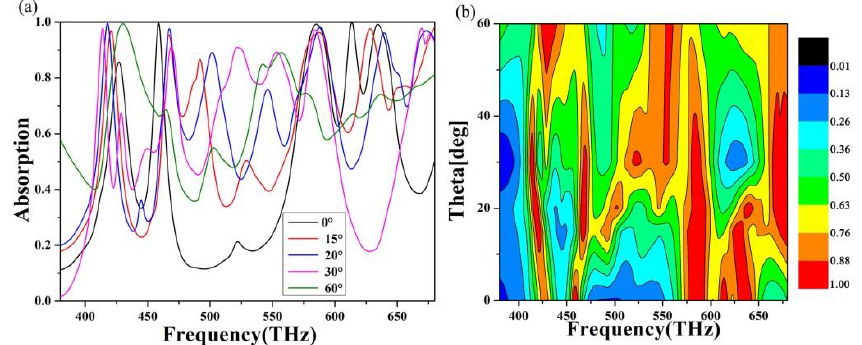
Figure 6. The absorption images at scanning incidence angle (0°–60°) at 380–680 THz ( a , b ).